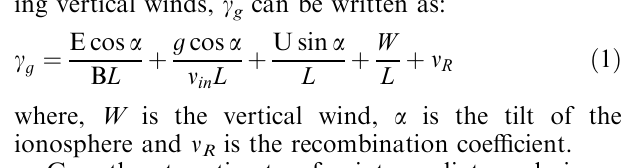
Fig. 3a–c. Power spectra of electron density irregularities in a large scale size range, covering intermediate, transitional and short scales, at three representative altitudes a 169, 172 and 176 km in the Valley region, b at 224, 246 and 278 km which lie near and below the F-region base and c at 291, 314 and 330 km which is the region below the F-peak. Each spectrum represents an altitude range of